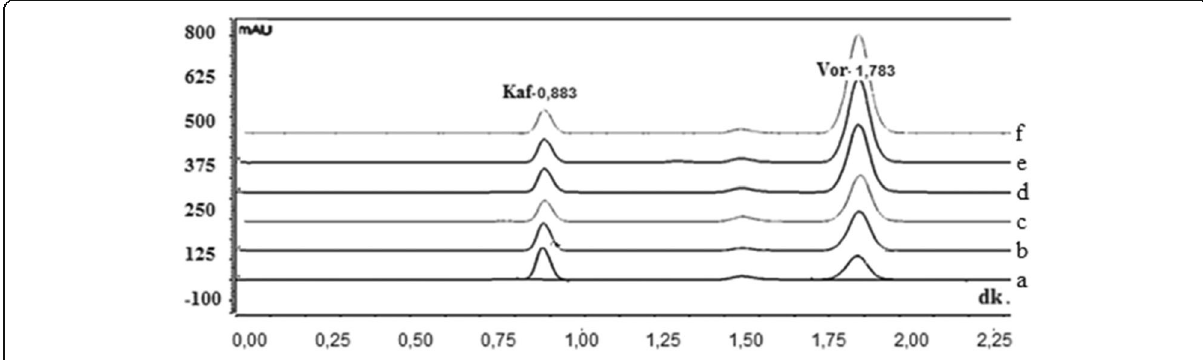
Fig. 2 Chromatograms of ( a ) 20.0 μ g mL − 1 , ( b ) 30.0 μ g mL − 1 , ( c ) 40.0 μ g mL − 1 , ( d ) 50.0 μ g mL − 1 , ( e ) 60.0 μ g mL − 1 , and ( f ) 70.0 μ g mL − 1 , VRT, and